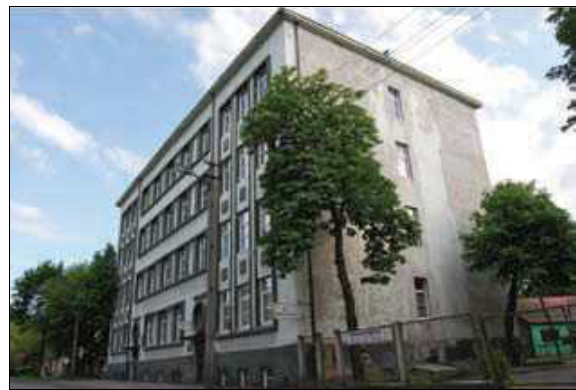
Fig. 1. Former nursing home in kaunas, 10 Aukštaičiai st (arch. k. reisonas), 1939